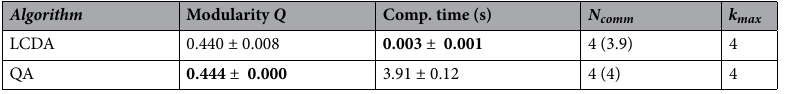
Table 1. Results of community detection on the karate club dataset. Modularity and computational time required for the algorithms to finish [MEAN ± STD]. For the case of QA the time was measured since the start of the communication with D-Wave and the return. The number of communities together with its mean in brackets. k max refers to the hyperparameter required for the algorithms to run. All results are averages of 100 different runs. Bold numbers indicate a better performance. The number of detected communities for classical and quantum computing is the same but the modularity is higher for the quantum annealer used. QA modularity’s STD was 8.85e−17.